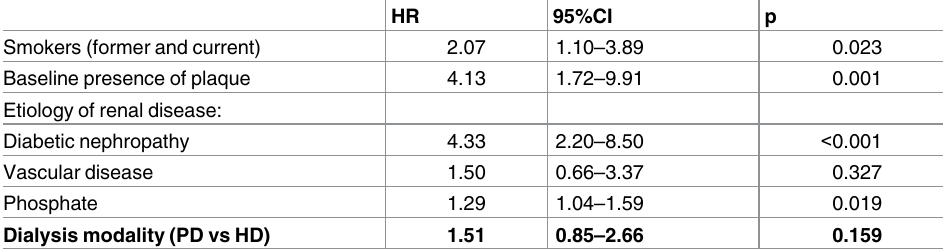
Table 5. Multiple Cox regression analysis for incident CV